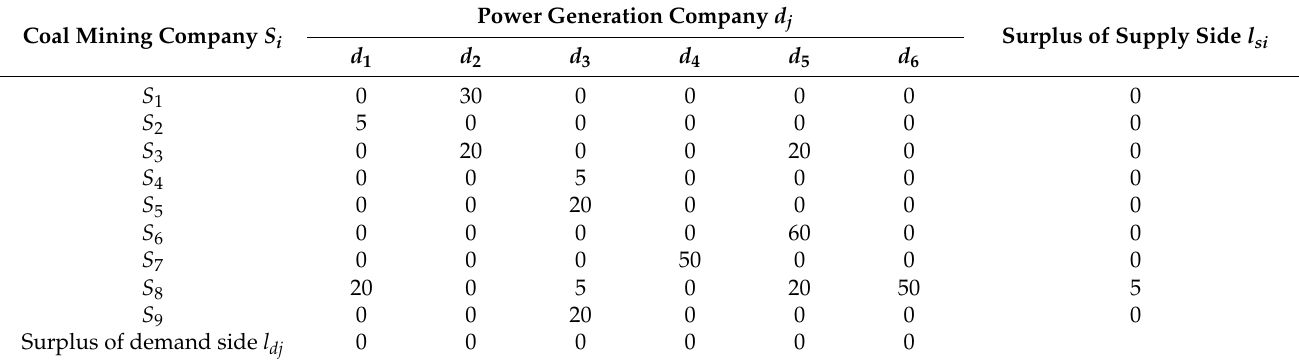
Table 2. Results of pairwise stable matching.